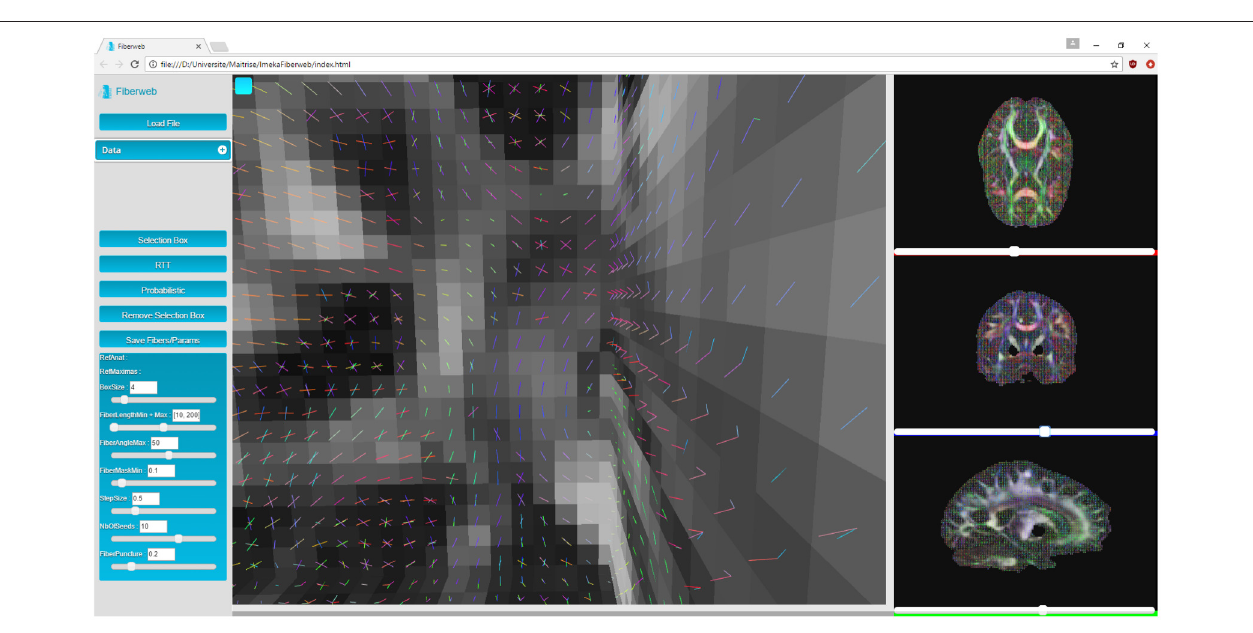
FIGURE 2 | Anatomy and peaks visualization in 3D and 2D views inside